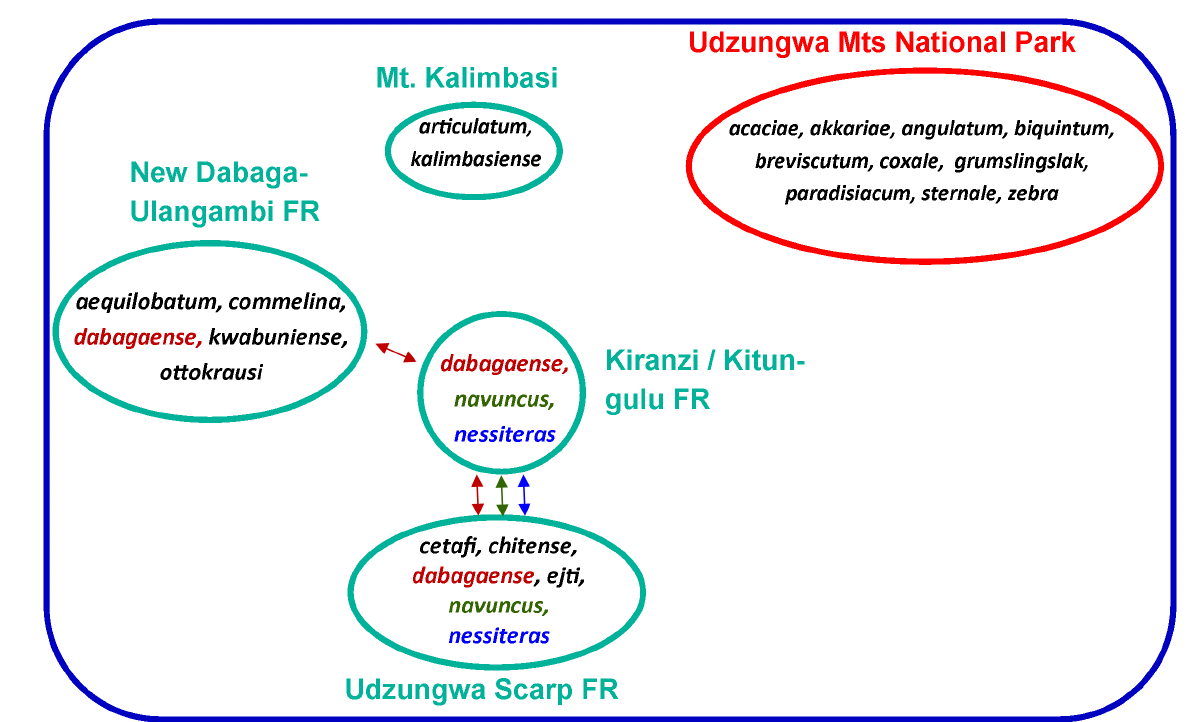
Fig. 37 . Distribution of species of Eviulisoma Silvestri, 1910, in the Udzungwa Mts. The positions of the ovals in relation to each other approximately correspond to the relative position of the Udzungwa Mts National Park, Mt Kalimbasi and the three forest reserves, cf. Fig. 2. Species shared between two or three areas are indicated with coloured text and double-headed